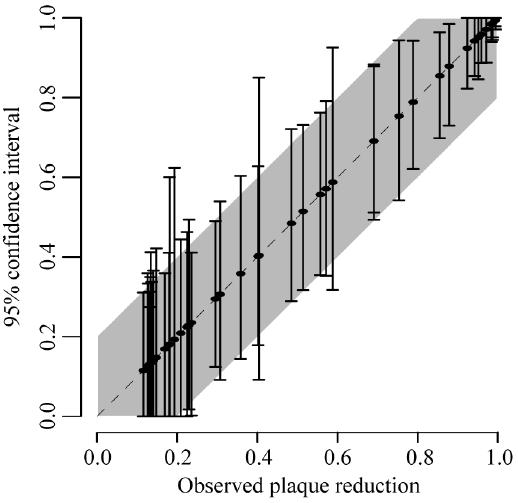
Figure 2. Plaque reduction proportions for individual dilutions. Each solid line represents the 2.5% and 97.5% quantiles of plaque reductions from the average of two repeats from a single dilution from a particular virus – serum pool combination. The shaded area represent asymptotic 95% confidence intervals calculated from the overall variance observed in the plaque reduction